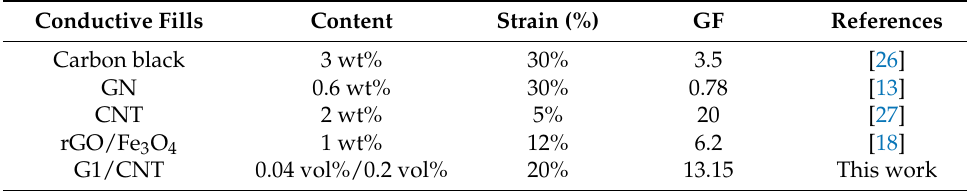
Table 2. Performance of flexible sensors based on PU matrix.